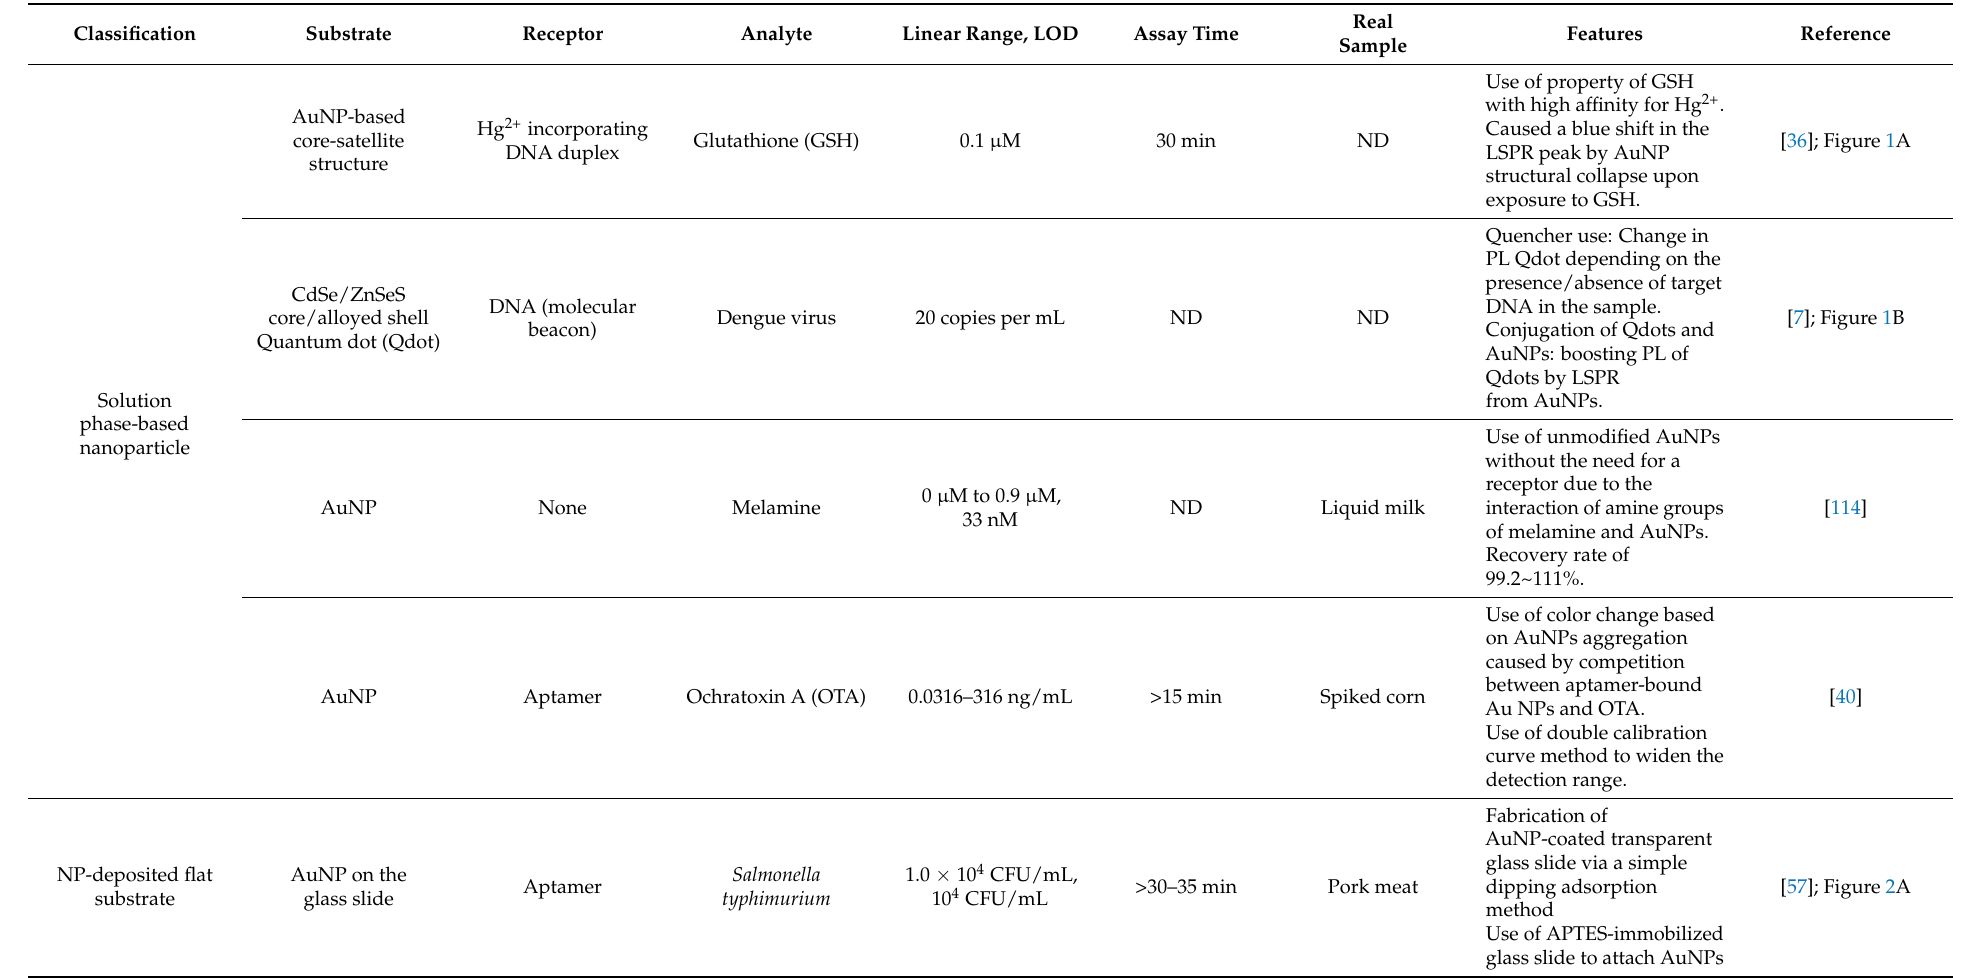
Table 1. Examples of nanostructure-based LSPR biosensors for the detection of various molecules a